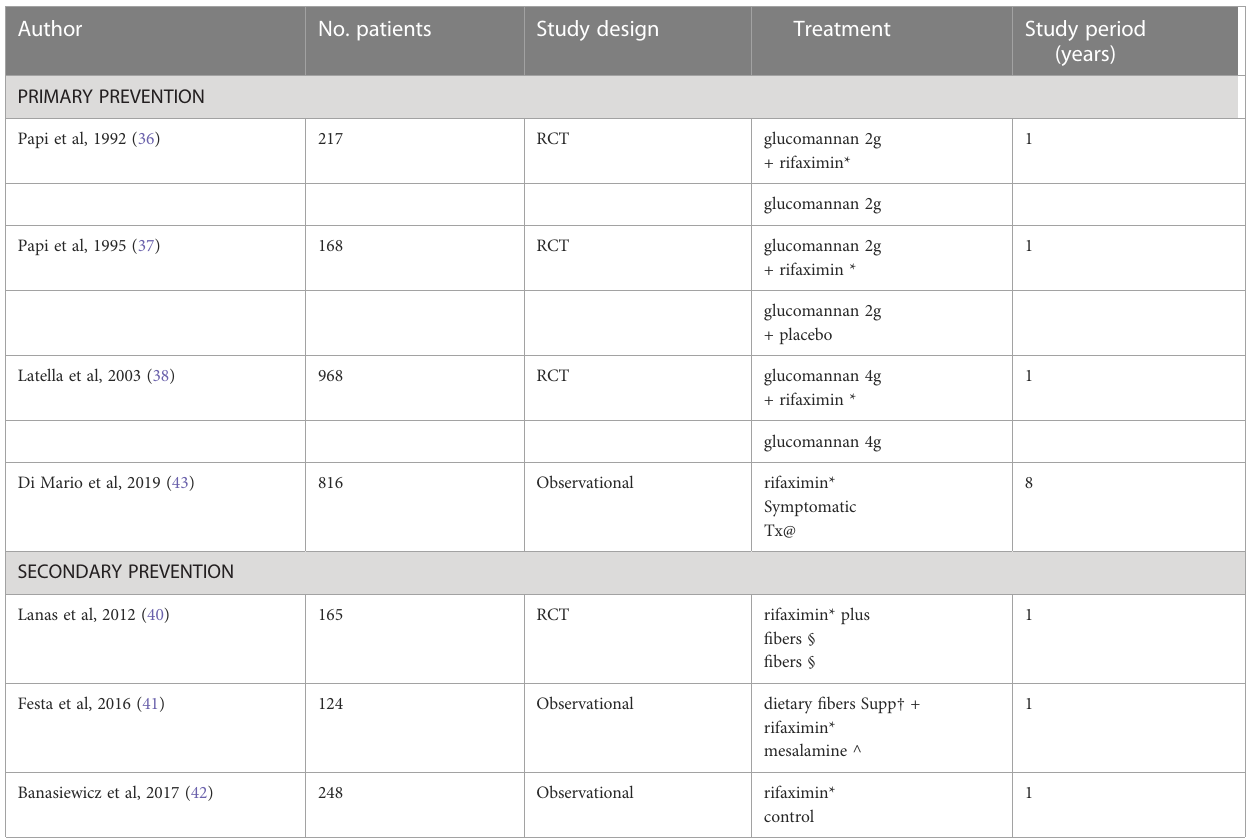
TABLE 1 Studies addressing non-absorbable antibiotic rifaximin in the prevention of